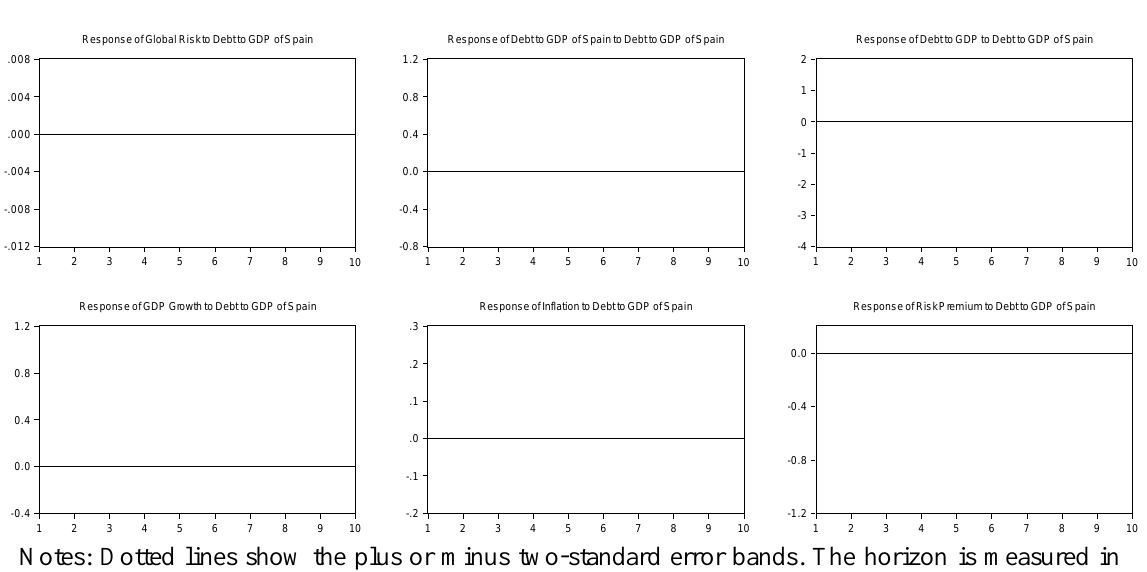
Figure 17. Response of EMU countries to a shock to Spain’s debt-to-GDP ratio during the crisis: 2008–2011.